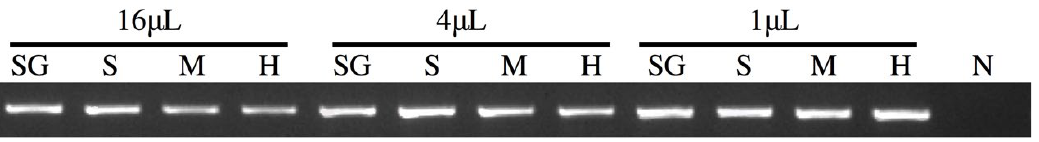
Figure 4. PCR results from DNA extracted from skin mucus by the swabbing and disc method. 1– 27, swabs from 27 crucian carp; N, no template control. The eluted DNA was used in a PCR reaction using primers designed for the 16s rRNA gene. Compared to the drawing of blood, the sampling process by swabbing was efficient and non-invasive. We, therefore, preferred the swabbing method to collect DNA samples from skin mucus. No fish used in the swabbing procedures had altered behavior and no swelling or inflammation appeared at the site of DNA collection 2 weeks post-sampling. Although the sterile nylon-tipped specimen collection swab is cheap and easy to obtain, it is not absolutely necessary as a common cotton swab could also be equally efficient and even replace the disc to collect the extracted DNA (data not shown), providing an even cheaper and accurate alternative. 3.4. Fish Size and Species To examine how fish body size affected the DNA yield recovered by the swabbing and disc method, three tilapias (~15 cm) and three medakas (~2.5 cm), together with three crucian carp (~7 cm) were swabbed. Swabbing medakas of the smallest size produced comparable results to the largest tilapia (Figure 5). To our surprise, the amount of ex- tracted DNA was not related to the size of the fish. Our results indicated that the mucus from the smallest fish (medaka, ~2.5 cm) could extract enough DNA for detection. Addi- tionally, without the use of anesthesia, the biggest fish (tilapia, ~15 cm) was hard to re- strain firmly which might have led to swabbing failure that indicated one sample from tilapia had a smaller amount of PCR product than the other fish. Therefore, the potential drawbacks of the swabbing method may include low DNA quantity or poor quality DNA as in the previous report [23]. Nonetheless, the results from sequencing showed all of the PCR products of the 16s rRNA gene could be used to identify those species of fish which